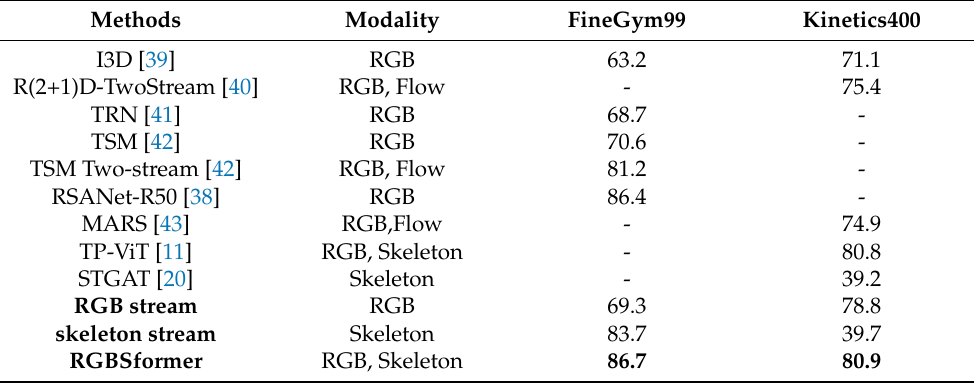
Table 1. The performance of RGBSformer and two single pathways on FineGym99 and Kinetics400 compared to state-of-the-art models. We report the mean-class accuracy for FineGym99 and Top-1 accuracy for Kinetics400. Units are in %.